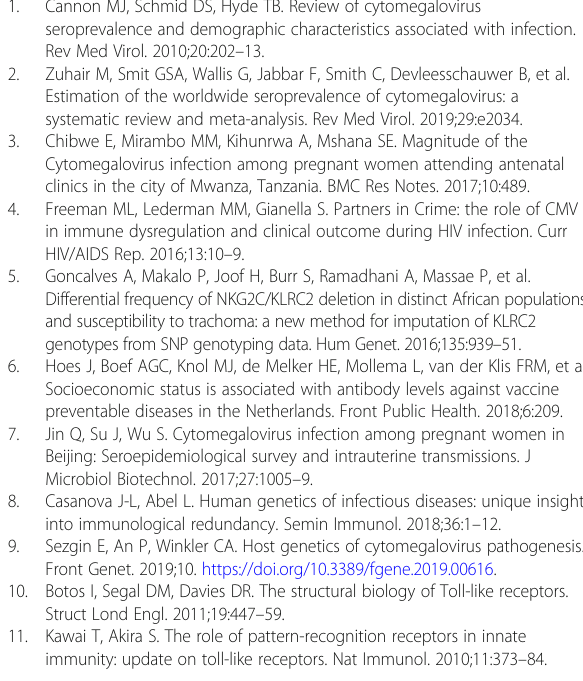
Additional file 1: Table 1. Genotype frequencies and univariate logistic regression of SNP with CMV infection status. Abbreviations CMV: Cytomegalovirus; TRL: Toll-like receptor; SNP: Single